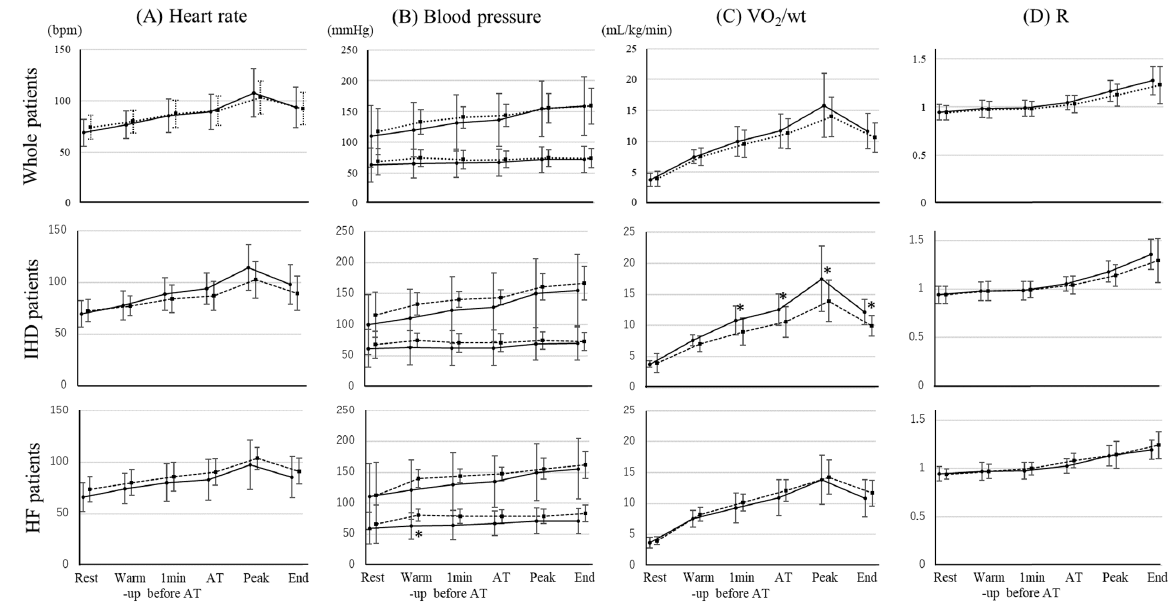
Figure 2. The differences of hemodynamics and exercise tolerance in CPET between normal HADS group and high HADS group in whole patients, IHD patients, and HF patients. ( A ) Heart rate, ( B ) blood pressure, ( C ) VO 2 /wt, and ( D ) respiratory exchange ratio in whole, IHD, and HF patients are shown. A solid line and circle marker indicates the normal HADS group and a dotted line and square marker indicates the high HADS group. CPET: cardiopulmonary exercise test, IHD: ischemic heart disease, HF: heart failure, VO2/Wt: oxygen uptake per weight, R: respiratory exchange ratio, and AT: anaerobic threshold. * p < 0.05.